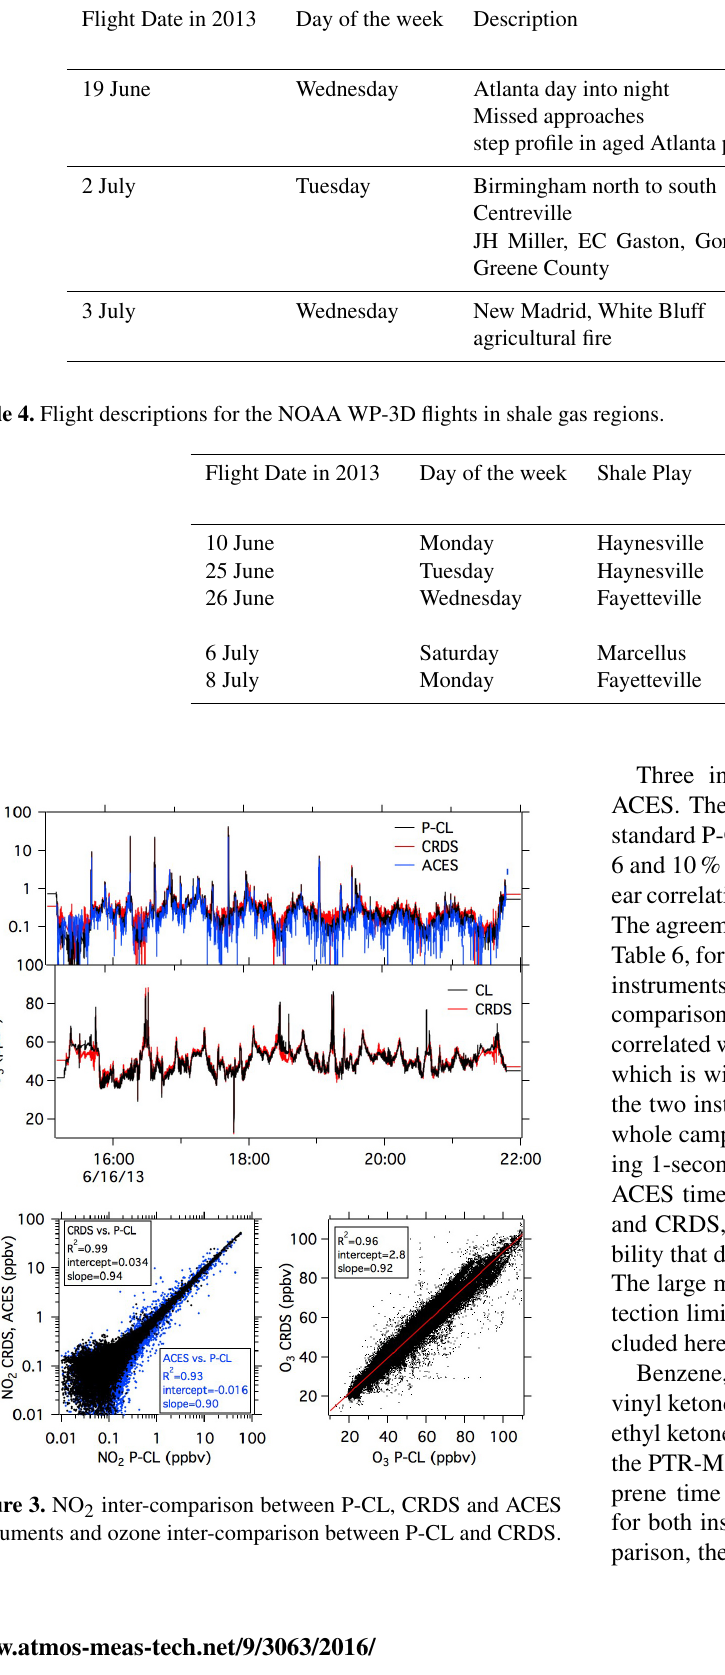
Table 3. Flight descriptions for the NOAA WP-3D nighttime flights in the SE US.